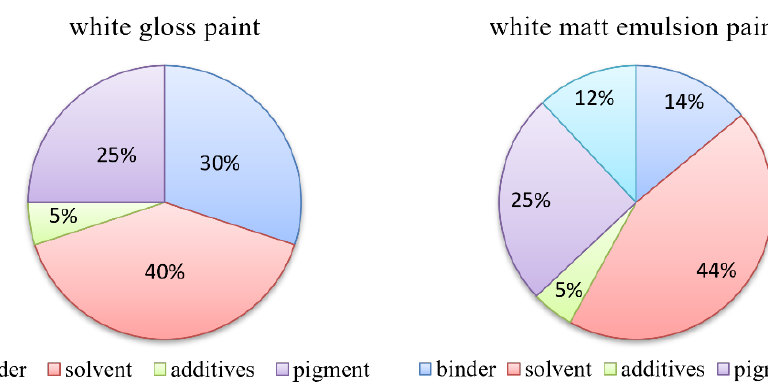
Figure 2. General paint composition [12].